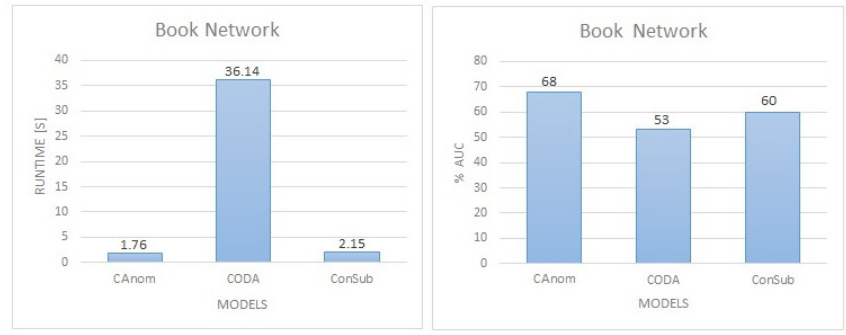
Figure 5. Quality and runtime evaluation for the Book network.